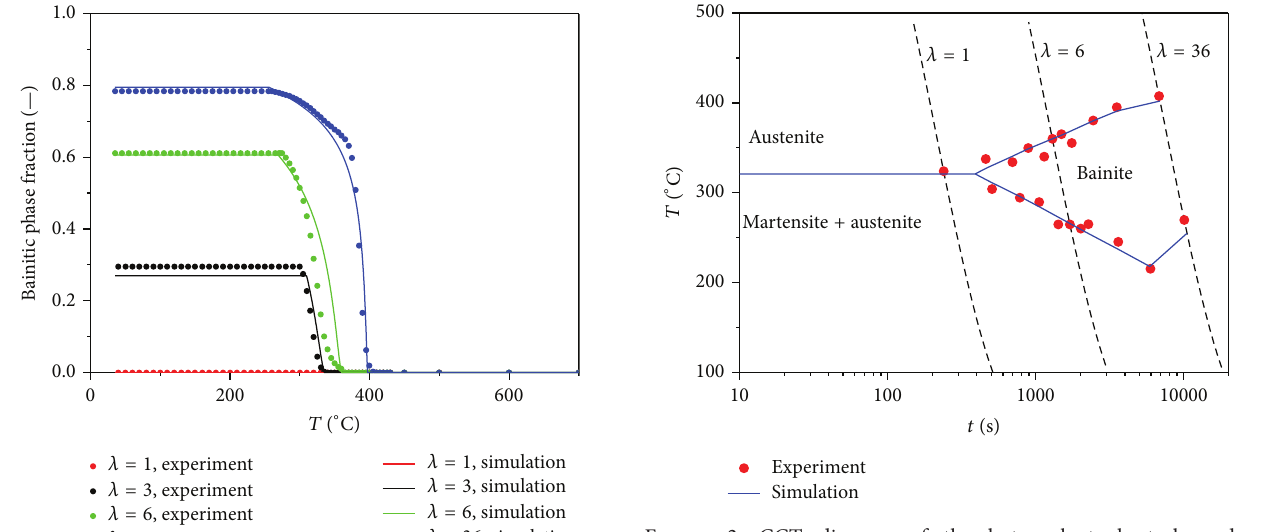
Figure 2: CCT diagram of the hot-work tool steel grade X36CrMoV5-1. The red dots mark the measured data points and the blue lines mark the calculated phase